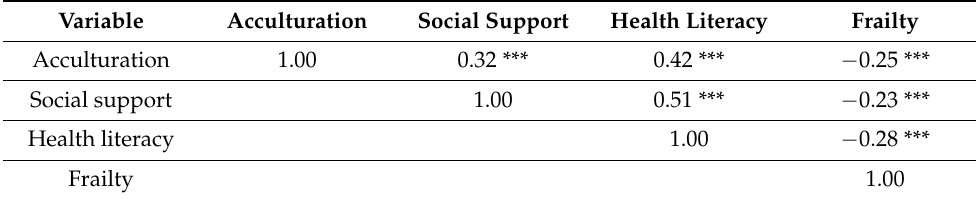
Table 2. Correlation coefficient of variables ( N = 244).